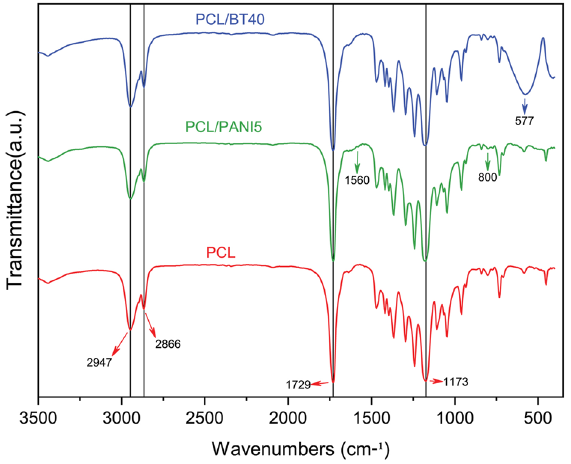
Figure 2. FTIR spectra of PCL, PCL/PANI5, and PCL/BT40 nanofibrous scaffolds. Studying the FTIR spectra of composite nanofibers reveals the presence of BT and PANI NPs within the fibrous